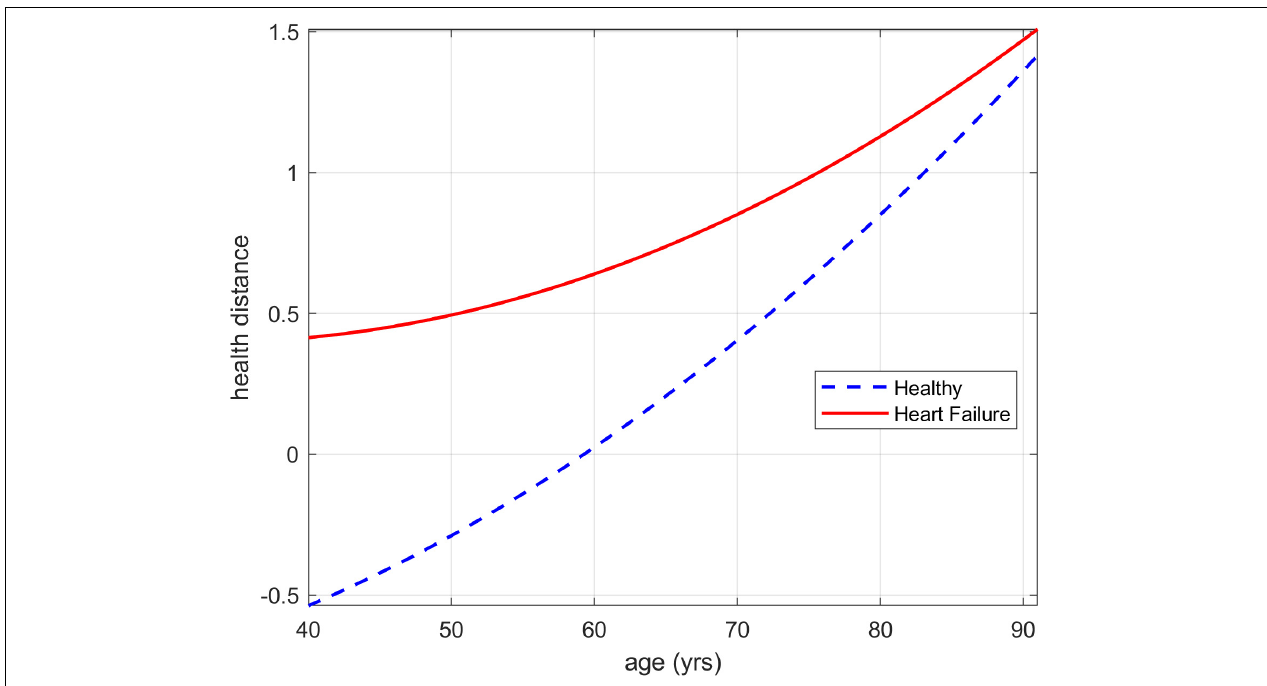
FIGURE 1 | Health distance trajectories for Fitness biomarkers for the Healthy and Heart Failure group presented from 40 to 91 years of age. The curves correspond to non-smoking females not taking medications.